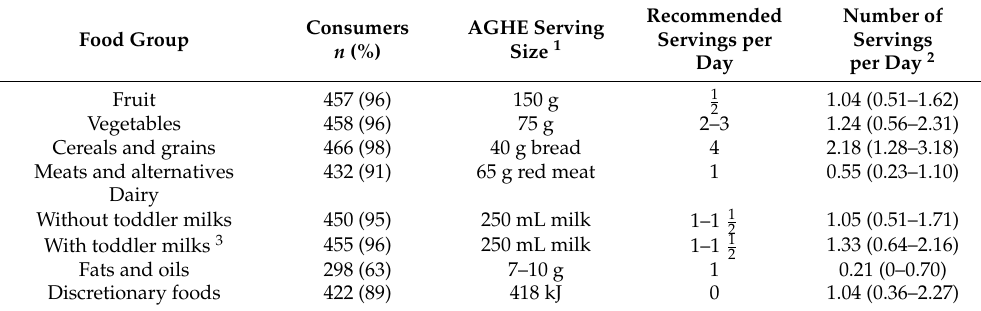
Table 2. Daily servings of five food groups and discretionary foods consumed by toddlers aged 12–24 months, OzFITS 2021 ( n =